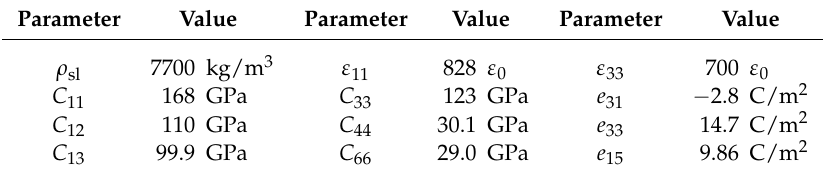
Table A1. Parameters for PZT transducer Pz26 [27] with damping coefficient Γ sl = 0.02 [28].